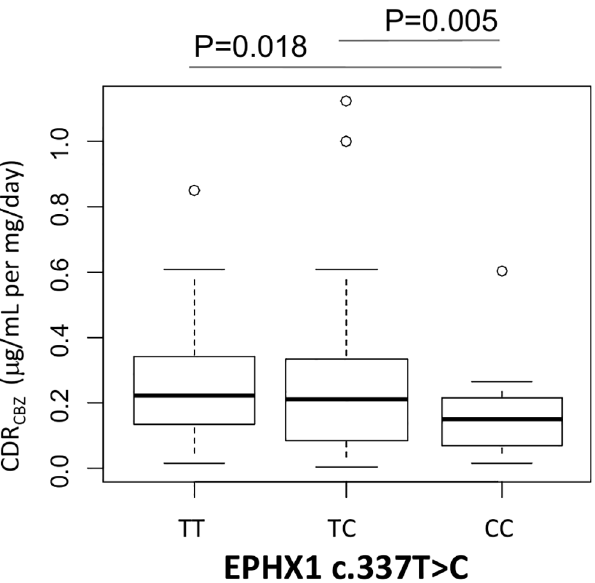
Fig 5. Graphical representations (box-plot) of the EPHX1 c.377T > C genotypes with CDR CBZ CBZ: Carbamazepine; CDR: Concentration/dose ratio. Data are mean ± standard deviations. Statistical significance for difference of means is shown (P values, one way ANOVA analysis followed by Student ’ s T- test).